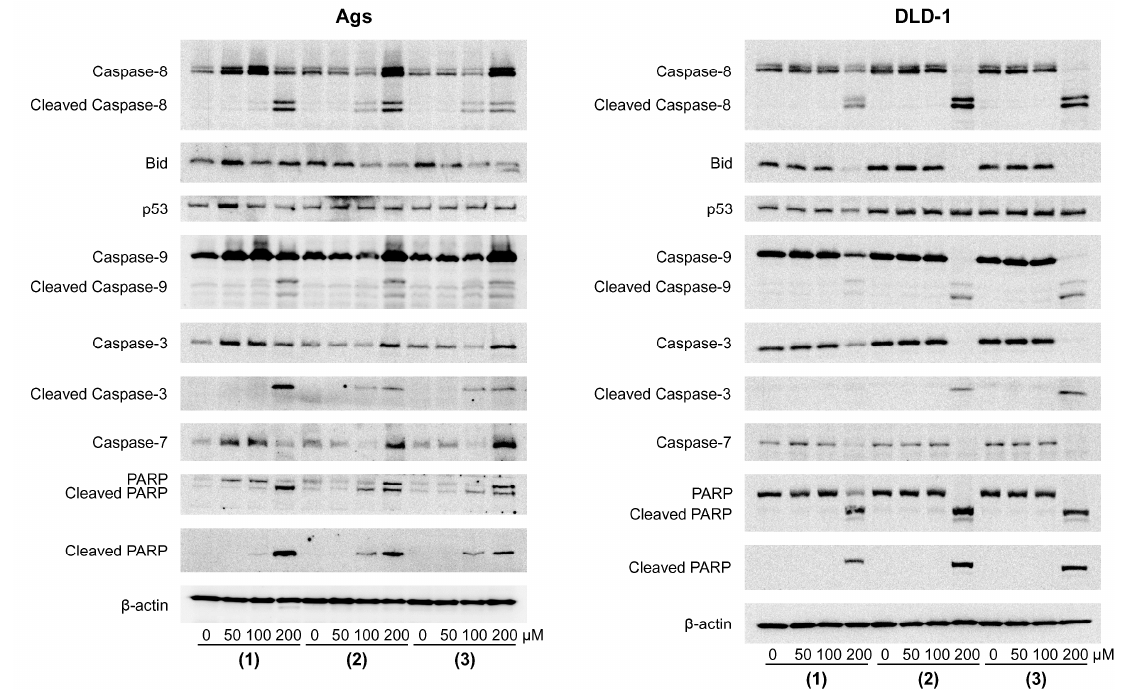
Figure 4. Triterpene seco -acids trigger extrinsic and intrinsic pathways of apoptosis in AGS and DLD-1 cells. AGS and DLD-1 cells were treated with 3,4- seco -urs-4(23),20(30)-dien-3-oic acid ( 1 ), 3,4- seco -olean-4(24)-en-19-oxo-3-oic acid ( 2 ), and 3,4- seco -urs-4(23),20(30)-dien-19-ol-3-oic acid ( 3 ) for 24 h, and the expression levels of apoptosis-related proteins were determined by Western blotting. Antibodies against caspase-8, BID, p53, caspase-9, caspase-3, cleaved caspase-3, caspase-7, PARP and cleaved PARP were used. The expression of β -actin served to normalize protein loading.